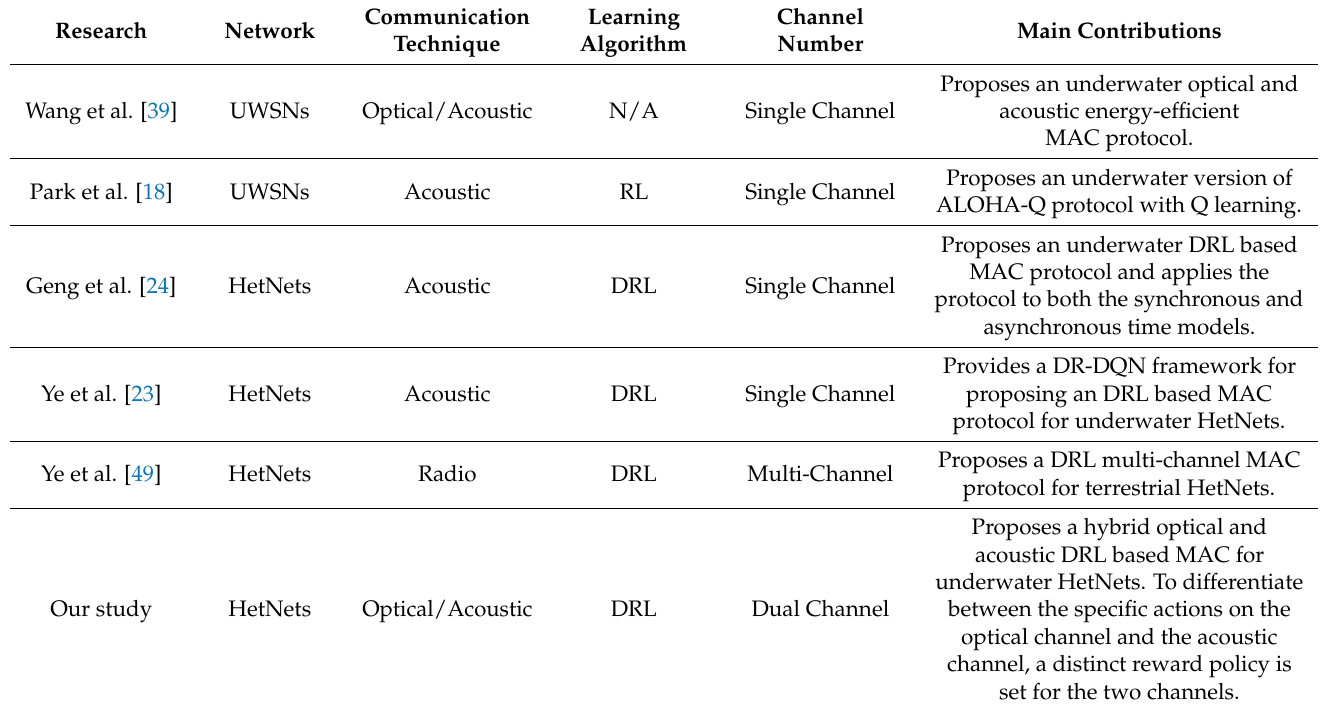
Table 1. A comparison of different network models. (DR-DQN: Delayed-Reward Deep Q-Network, HetNets: Heterogeneous